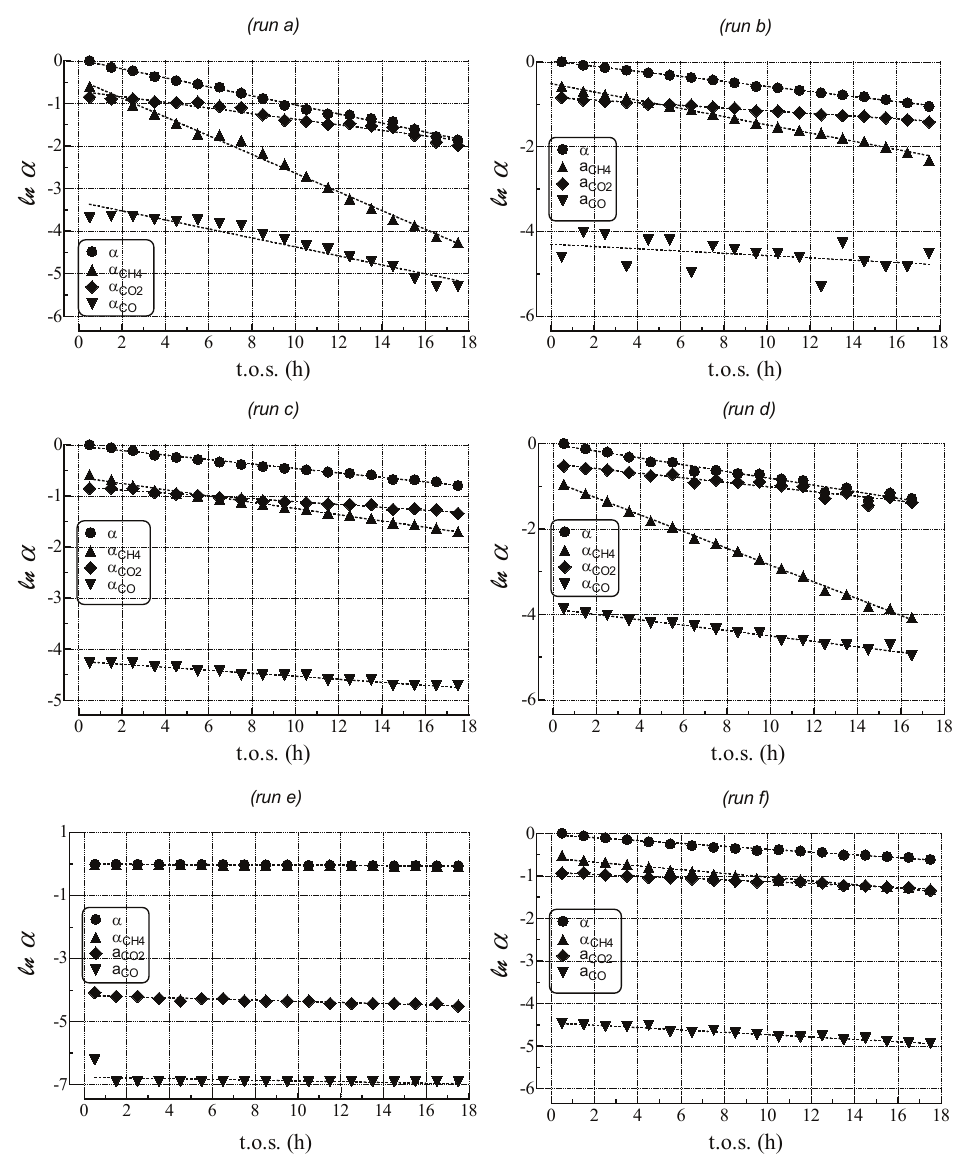
Figure 8. Relative rates of hexane conversion ( α ,  ), CH CO ( α ,  ) formation vs. t.o.s. at different reaction conditions (see Table 1) (adapted CO from ref. [15] with the kind permission of Wiley, copyright